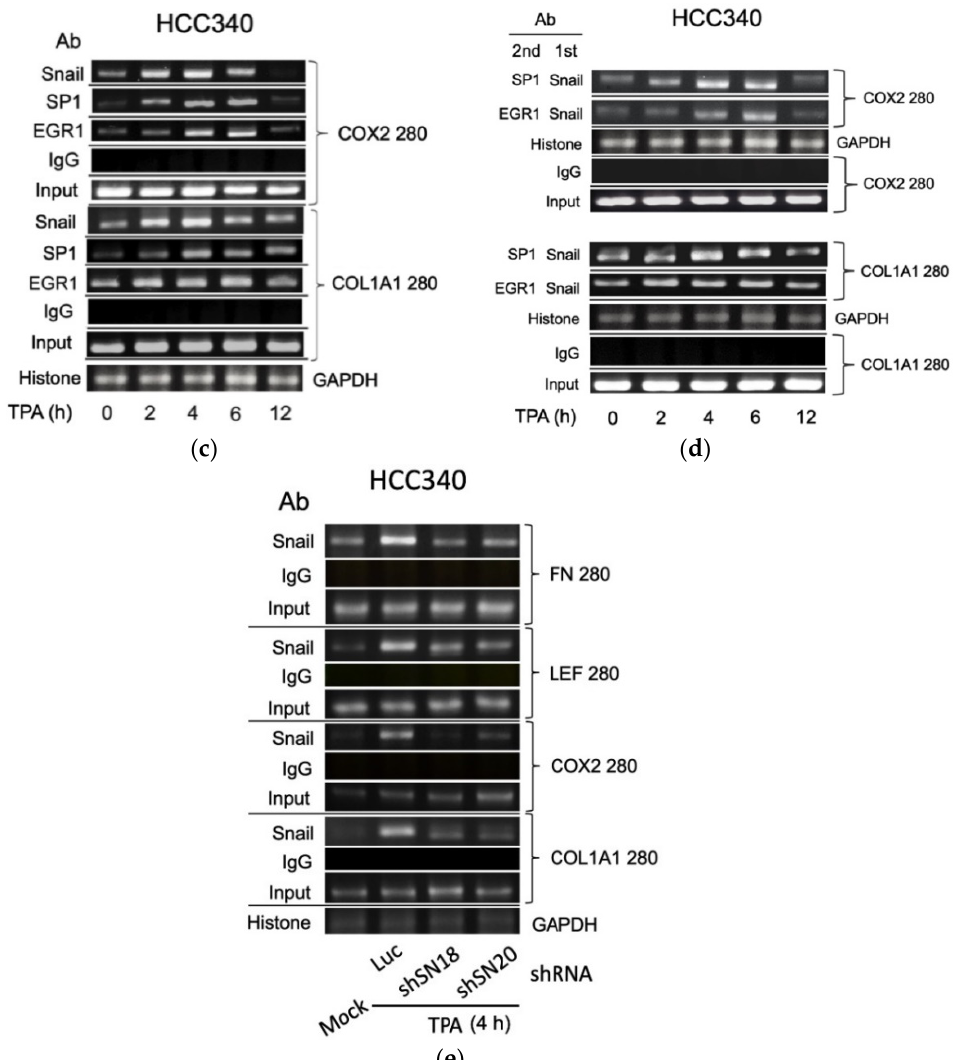
Figure 5. ChIP and double ChIP assay for TPA-induced binding of transcription factors on promoter of FN, LEF, COX2, and COL1A1. HCC340 cells were treated with TPA at the indicated time ( a – d ). HCC340 cells were transfected with indicated shRNA for 48 h, followed by treatment of TPA for 4h ( e ). Single ChIP for binding an indicated transcription factor on indicated promoter fragment ( a , c , e ) and double ChIP for the association of indicated factors on indicated promoter fragments ( b , d ) were performed using conventional PCR. In ( a – e ), IgG was used as the antibody control and histone binding on GAPDH promoter as positive control. Input was for normalizing the amount of DNA loaded for ChIP. The data shown were representatives of two reproducible experiments.